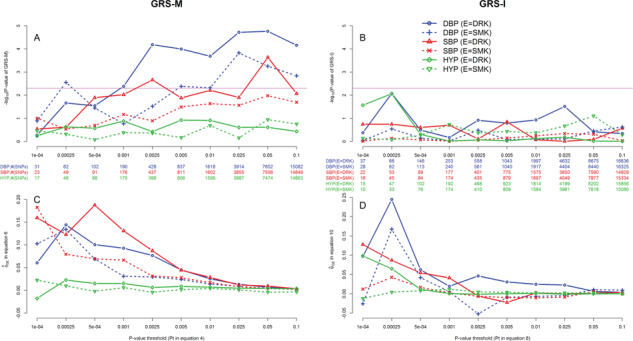
TWB analysis results using the GRS-M and GRS-I tests. The left and right columns show the GRS-M and GRS-I results, respectively. The black x-axes list the 10 P-value thresholds, i.e. \documentclass[12pt]{minimal}
\usepackage{amsmath}
\usepackage{wasysym}
\usepackage{amsfonts}
\usepackage{amssymb}
\usepackage{amsbsy}
\usepackage{upgreek}
\usepackage{mathrsfs}
\setlength{\oddsidemargin}{-69pt}
\begin{document}
}{}${P}_t$\end{document} in Equations (4) or (8). The blue (for DBP analysis), red (for SBP analysis) and green (for HYP analysis) x-axes list the number of SNPs used to construct \documentclass[12pt]{minimal}
\usepackage{amsmath}
\usepackage{wasysym}
\usepackage{amsfonts}
\usepackage{amssymb}
\usepackage{amsbsy}
\usepackage{upgreek}
\usepackage{mathrsfs}
\setlength{\oddsidemargin}{-69pt}
\begin{document}
}{}${GRS}_M$\end{document} or \documentclass[12pt]{minimal}
\usepackage{amsmath}
\usepackage{wasysym}
\usepackage{amsfonts}
\usepackage{amssymb}
\usepackage{amsbsy}
\usepackage{upgreek}
\usepackage{mathrsfs}
\setlength{\oddsidemargin}{-69pt}
\begin{document}
}{}${GRS}_I$\end{document}. The y-axes of plots (A) and (B) are \documentclass[12pt]{minimal}
\usepackage{amsmath}
\usepackage{wasysym}
\usepackage{amsfonts}
\usepackage{amssymb}
\usepackage{amsbsy}
\usepackage{upgreek}
\usepackage{mathrsfs}
\setlength{\oddsidemargin}{-69pt}
\begin{document}
}{}$-{\log}_{10}$\end{document}(P-value of GRS-M) and \documentclass[12pt]{minimal}
\usepackage{amsmath}
\usepackage{wasysym}
\usepackage{amsfonts}
\usepackage{amssymb}
\usepackage{amsbsy}
\usepackage{upgreek}
\usepackage{mathrsfs}
\setlength{\oddsidemargin}{-69pt}
\begin{document}
}{}$-{\log}_{10}$\end{document}(P-value of GRS-I), respectively. Considering the 10 P-value thresholds used for the GRS, the Bonferroni-corrected significance level to control the FWER at 5% is \documentclass[12pt]{minimal}
\usepackage{amsmath}
\usepackage{wasysym}
\usepackage{amsfonts}
\usepackage{amssymb}
\usepackage{amsbsy}
\usepackage{upgreek}
\usepackage{mathrsfs}
\setlength{\oddsidemargin}{-69pt}
\begin{document}
}{}$.05\!\left/ \!10\right.=.005$\end{document}. The pink horizontal lines in plots (A) and (B) mark \documentclass[12pt]{minimal}
\usepackage{amsmath}
\usepackage{wasysym}
\usepackage{amsfonts}
\usepackage{amssymb}
\usepackage{amsbsy}
\usepackage{upgreek}
\usepackage{mathrsfs}
\setlength{\oddsidemargin}{-69pt}
\begin{document}
}{}$-{\log}_{10}$\end{document}(0.005) = 2.3. Moreover, \documentclass[12pt]{minimal}
\usepackage{amsmath}
\usepackage{wasysym}
\usepackage{amsfonts}
\usepackage{amssymb}
\usepackage{amsbsy}
\usepackage{upgreek}
\usepackage{mathrsfs}
\setlength{\oddsidemargin}{-69pt}
\begin{document}
}{}${\phi}_{GE}$\end{document} and \documentclass[12pt]{minimal}
\usepackage{amsmath}
\usepackage{wasysym}
\usepackage{amsfonts}
\usepackage{amssymb}
\usepackage{amsbsy}
\usepackage{upgreek}
\usepackage{mathrsfs}
\setlength{\oddsidemargin}{-69pt}
\begin{document}
}{}${\psi}_{GE}$\end{document} are estimated from Equations (6) and (10), respectively, and are shown in the y-axes of plots (C) and (D).